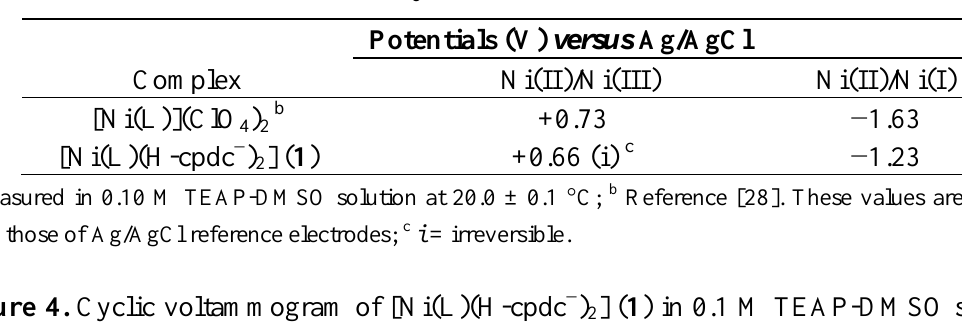
] ( 1 ) in 0.1 M TEAP-DMSO solution 2